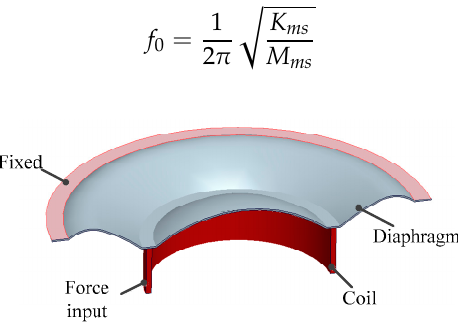
Figure 15. Mechanical system model and boundary conditions.